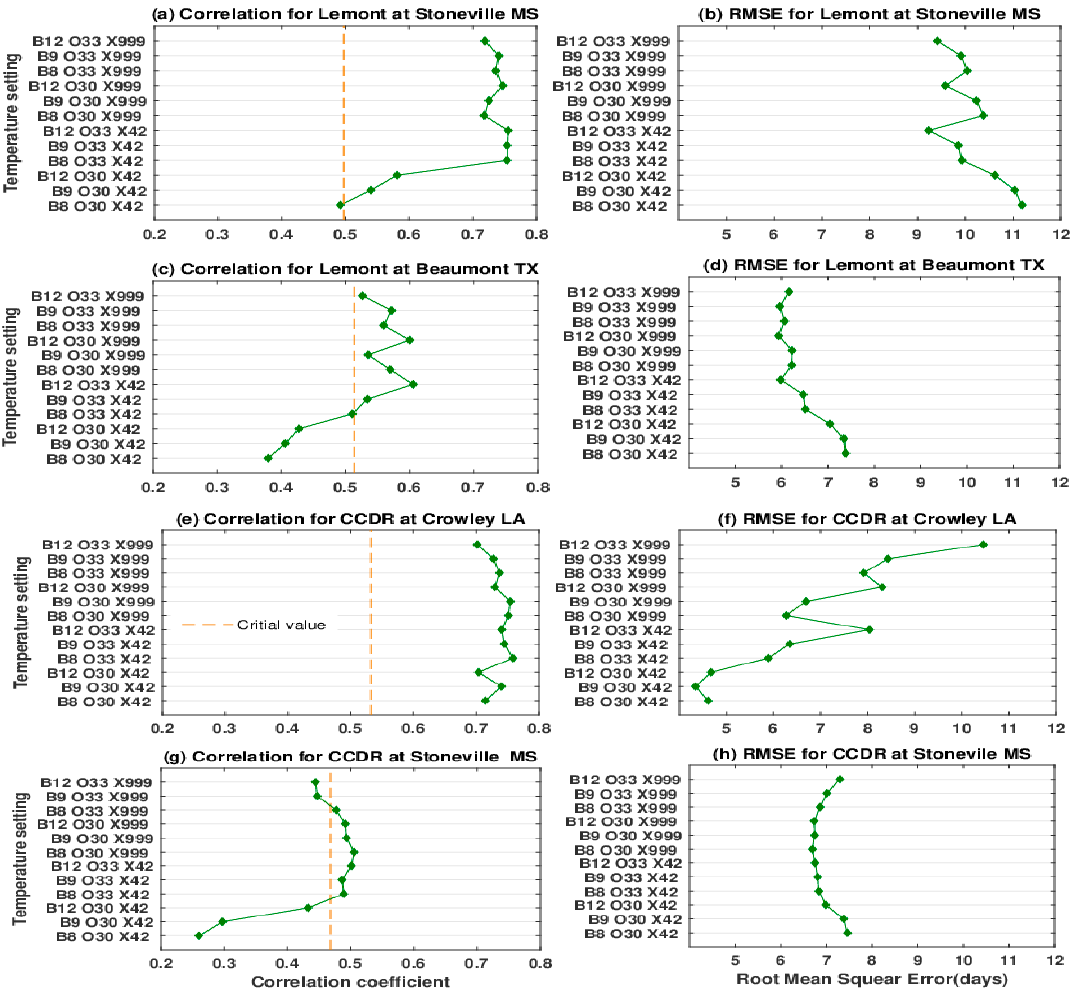
Figure 2. Correlation coefficients and Root Mean Square Error (RMSE) between observed and simulated growth durations from ORYZA with varying cardinal temperatures. Scenarios included cultivar Lemont at Stoneville, MS and Beaumont, TX for 1983–1998 ( a – d ) and Cocodrie (CCDR) grown at Crowley, LA and Stoneville, MS for 1999–2016 ( e – h ). Default values were 8, 30, and 42 °C for base, optimal, and maximum, respectively (e.g., B8 O30 X42 on the y-axis). Results for variations in base (B8, B9, or B12 °C), optimal (O30 or O33 °C), and maximum (X42 and X999 °C) values were evaluated.